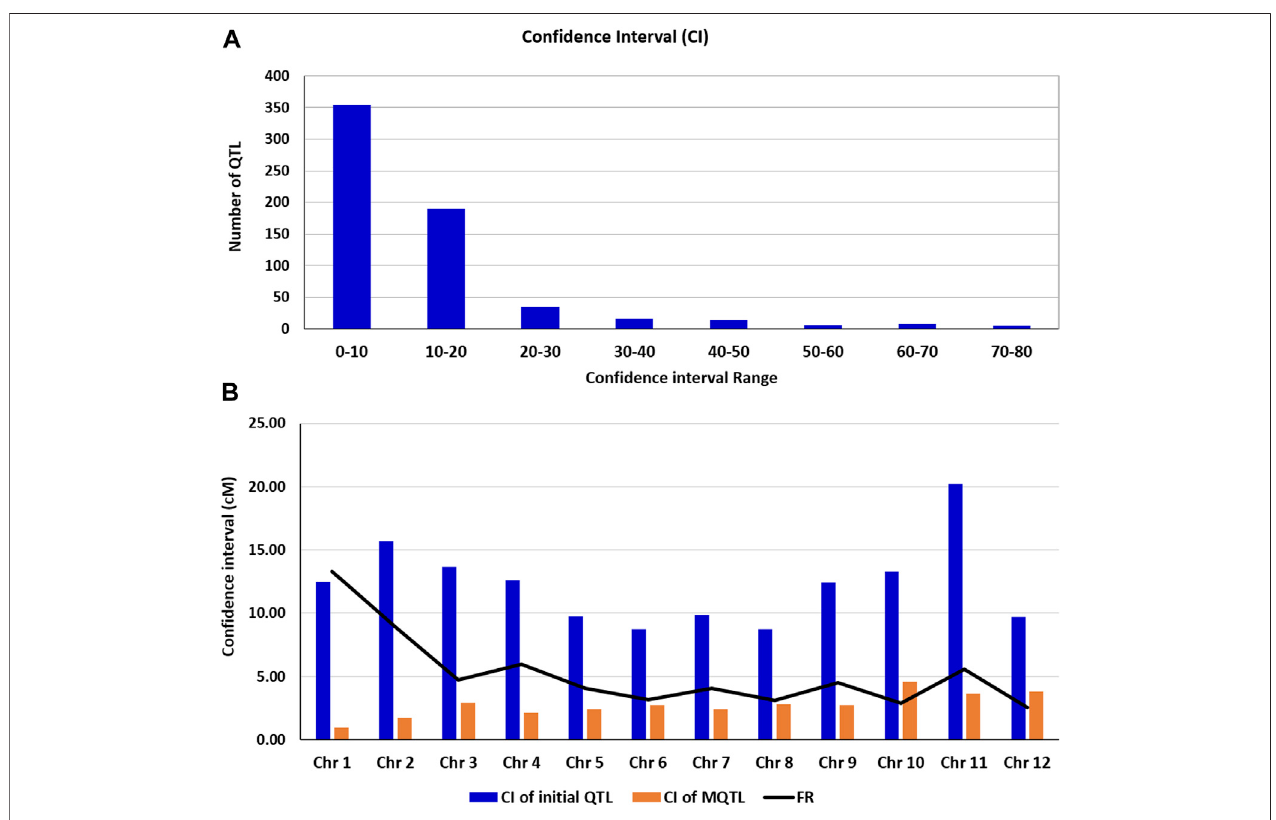
FIGURE2 | (A) Frequencies ofQTL withdifferent sizes ofcon fi dence interval (in cM) (B) (b) Comparison ofcon fi dence intervals (CIs) ofthe QTL and those ofmeta- QTL (MQTL), showing the fold level of reduction (FR) in the size of CI.